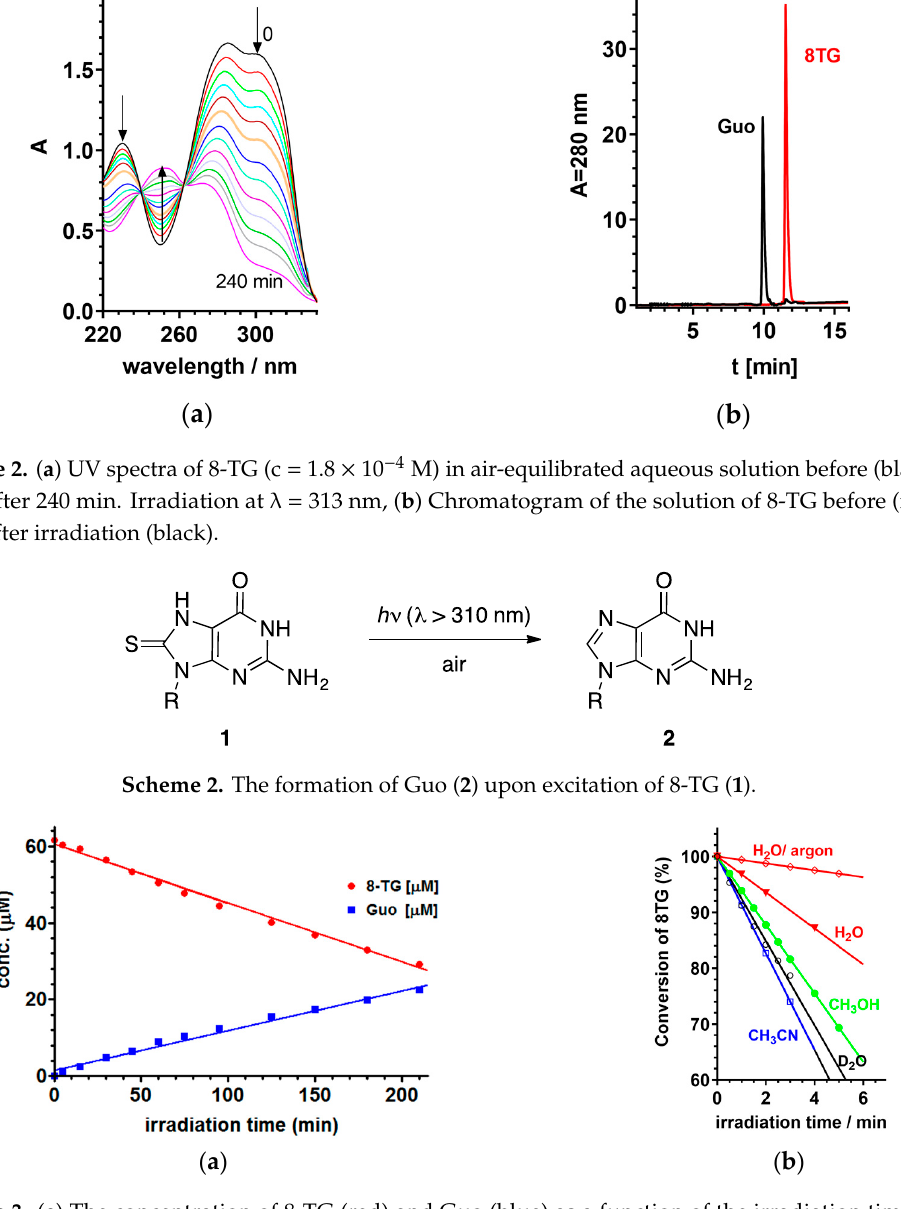
Figure 3. ( a ) The concentration of 8-TG (red) and Guo (blue) as a function of the irradiation time in air-equilibrated aqueous solution. ( b ) Rates of substrate disappearance upon radiation at λ > 300 nm of 8-TG in air-equilibrated solutions with different solvents.